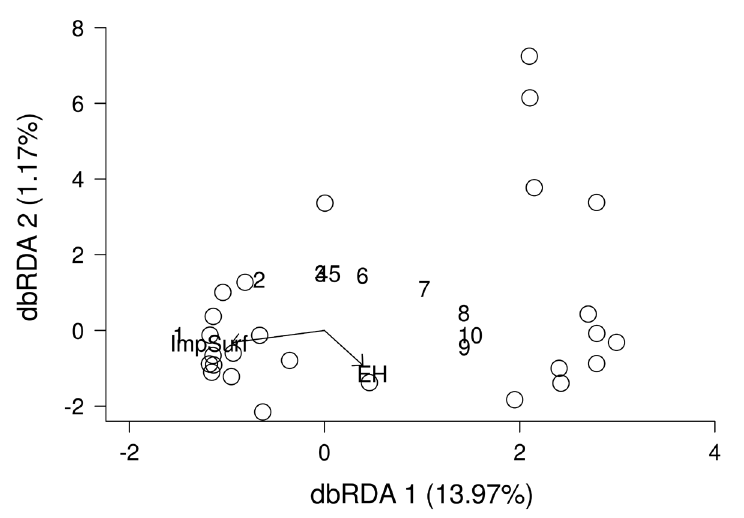
FIGURE 6 | Ordination of fish species composition by distance-based redundancy analysis (dbRDA) in relation to environmental heterogeneity (EH; estimated from environmental data and transformed by (x) prior to dbRDA) and the proportion of impervious surfaces (ImpSurf). Species codes, 1: Poecilia log e reticulata ; 2: Corydoras aeneus ; 3: Phenacogaster jancupa ; 4: Astyanax abramis ; 5: Hoplias malabaricus ; 6: Hypostomus khimaera ; 7: Serrapinnus calliurus ; 8: S. microdon ; 9: Hemigrammus tridens ; 10: A. lacustris .